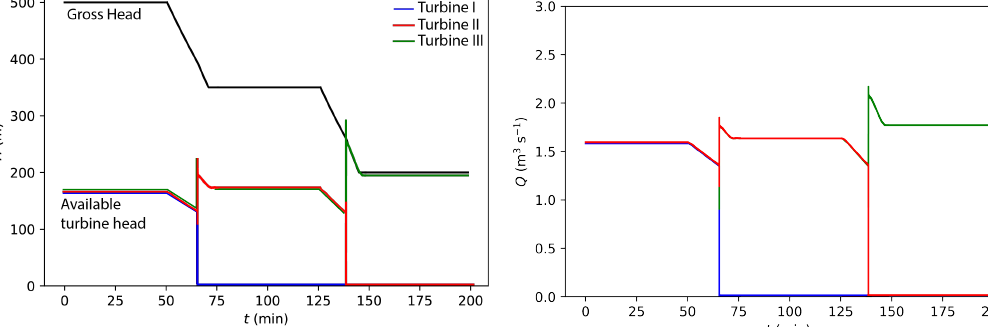
Figure 12. Time history of the gross head, available head ( left ), and discharge ( right ) of each Francis turbine for the operating conditions presented in scenario